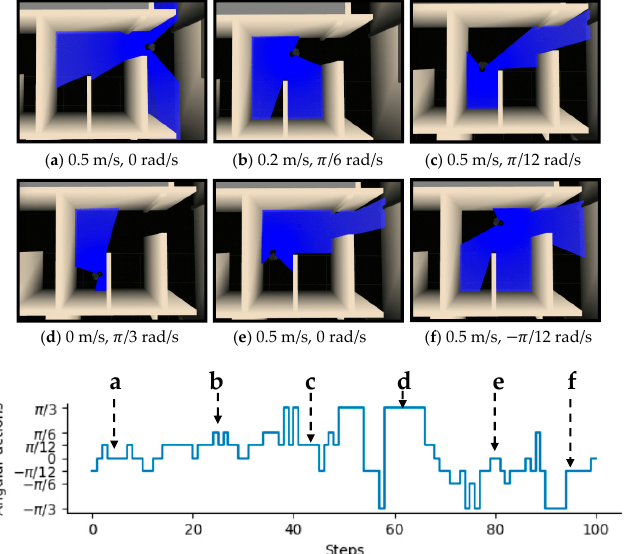
Editable version Figure 6. An example of dealing with dead end in virtual testing environment. The subfigures show the top view of six intermediate time steps and the sub-captions indicate the corresponding linear and angular velocity commands. Angular velocity commands in all time steps are provided at the